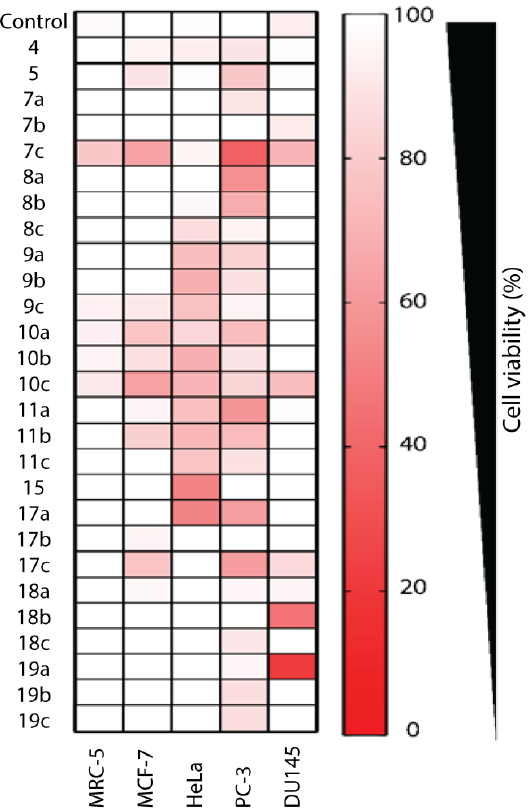
Figure 2. Heat map representation of the primary cytotoxic effects of novel A-ring-modified estradiol derivatives and their structurally simplified non-steroidal pairs on different cell lines (compound concentration = 2.5 μM; incubation time = 72 h). Control represents the viability of untreated cells.